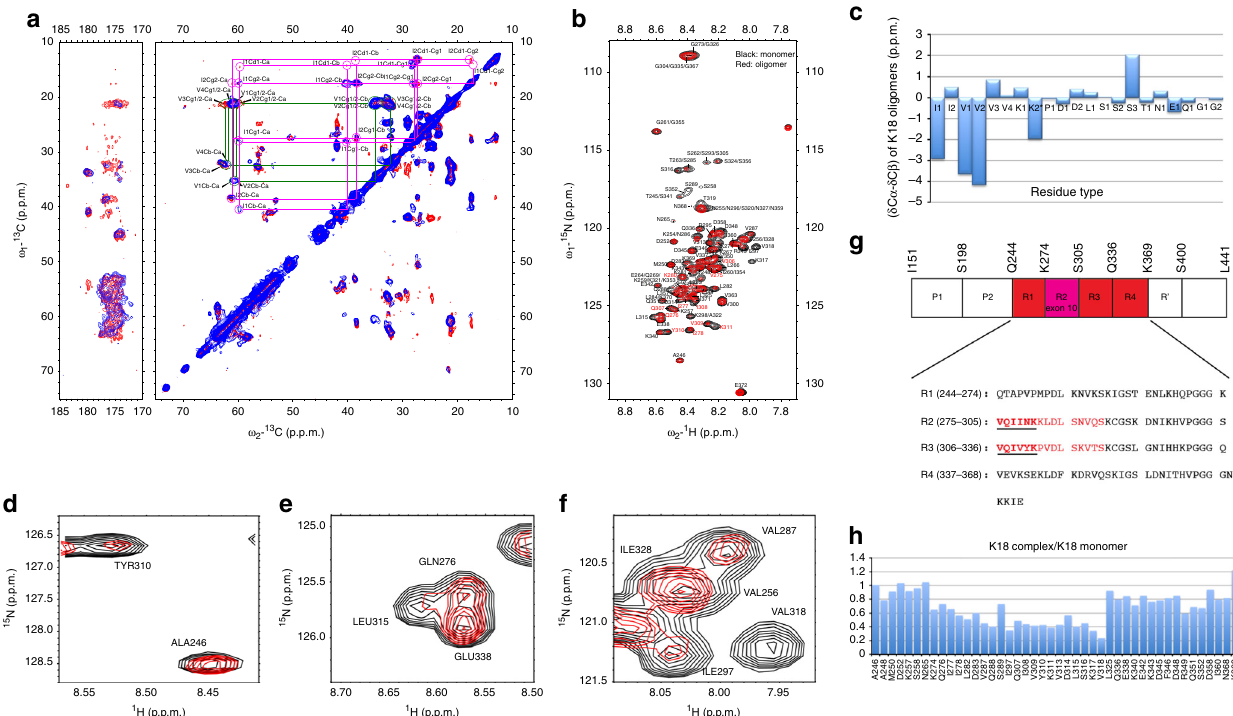
Fig. 5 Identi fi cation of residues that form the K18/phospholipid oligomer core. a Valine and isoleucine spin system assignments showing the presence of two Val residues and one Ile residue in a β -strand conformation (signals shifted down and right re fl ect decreased C α and increased C β shifts characteristic of β -strand). b Proton-nitrogen HSQC spectrum of a K18/phospholipid complex preparation in solution (red), compared with a matching spectrum of the monomeric protein (black). Resonance assignments are indicated, with red labels for the PHF6 and PHF6* regions. c Secondary carbon chemical shifts (C α - C α _rc + C β -C β _rc) by amino acid type for signals observed in DARR spectra of K18/phospholipid complexes. Lys-2 is marked with an asterisk to indicate that this tentatively assigned lysine residue exhibits chemical shifts consistent with a pre-proline residue, indicating that it corresponds to residue Lys-311. d – f Regions from the proton-nitrogen correlation HSQC spectra of complexes suspended in solution (red), compared with matching spectra of the monomeric protein (black). The signals from the PHF6 region (Tyr-310 and Leu-315), from the PHF6* region (Gln-276), and from the ~9 residues subsequent to each PHF motif (Val-287 and Val-318) are highly attenuated, indicating their immobilization in the oligomer core. Signals from other regions of K18 are much less affected, indicating that they remain highly fl exible outside the oligomer core. Signals from Ile-297 and Ile-328 also show some attenuation, possibly resulting from their close proximity to regions within the core, which likely restricts their mobility. g Schematic of the K18 sequence and its location within full-length Tau, highlighting in red the residues that appear to form the oligomer core. The hexapeptide motifs PHF6 and PHF6* are underlined and in bold type. h Ratios of intensities for well resolved signals in HSQC spectra of protein/phospholipid complexes versus monomers, showing that the PHF6 region and subsequent ~9 residues, are most highly attenuated, but that the corresponding region in repeat 2, including the PHF6* motif and subsequent ~9 residues are also signi fi cantly attenuated compared to the remainder of the